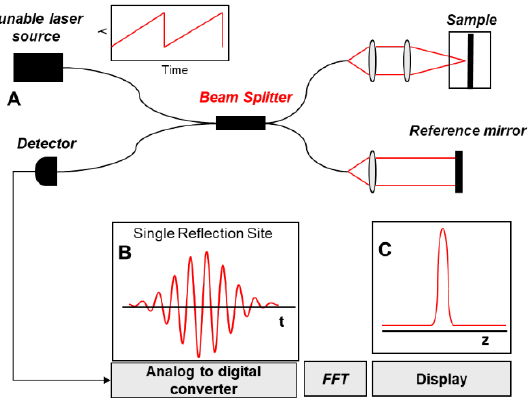
Figure 3. ( A ) Fiber-optic implementation of swept source low coherence interferometer, ( B ) interferogram, and ( C ) back reflection profile.